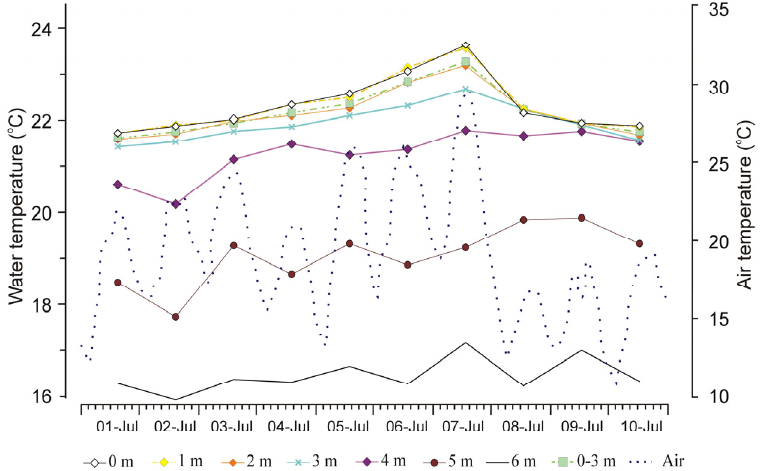
Figure 2. The course of the mean water temperature at depths of 0, 1, 2, 3, 4, 5 and 6 m and the average water temperature at 0–3 m in Lake ´Slesi´nskie in the period from 1 to 10 July 1969 according to data from Chojnowski